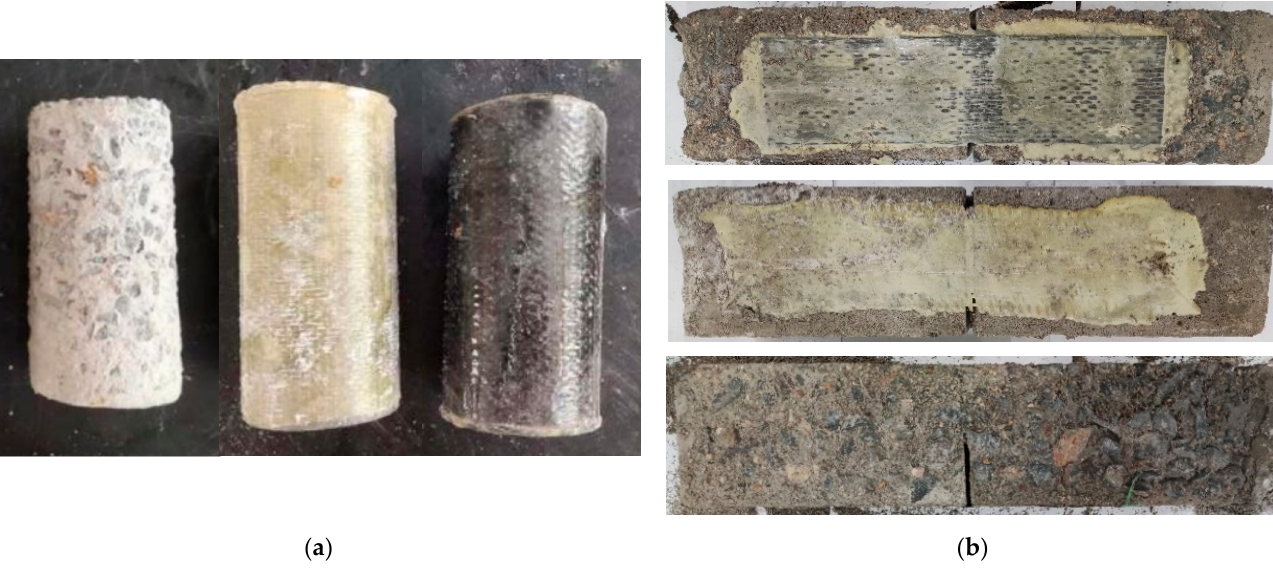
Figure 5. Surface morphology of specimens after freeze–thawing: ( a ) cylindrical specimens after 100 freeze-thawing cycles; ( b ) prismatic specimens after 100 freeze-thawing cycles.